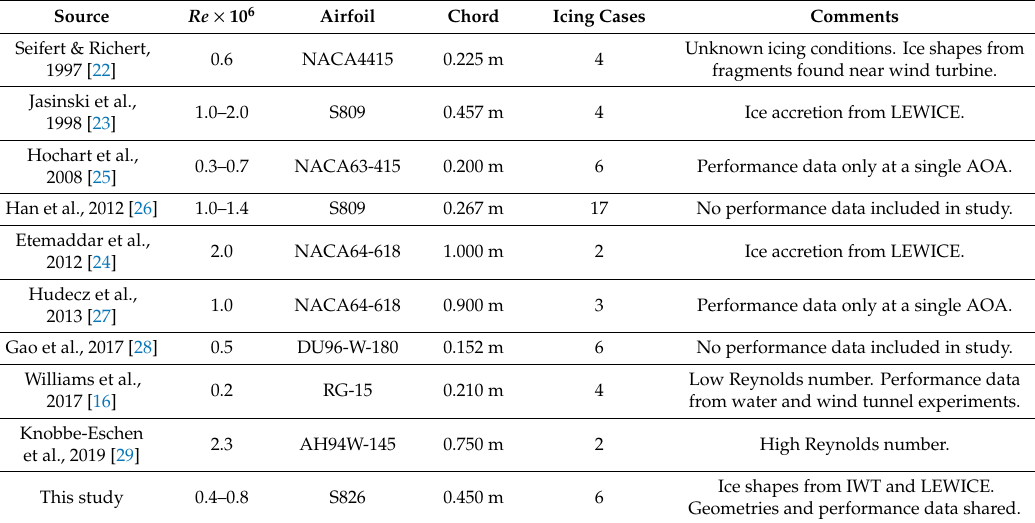
Table 1. Overview of existing data in the literature on airfoil performance degradation on iced airfoils at low Reynolds